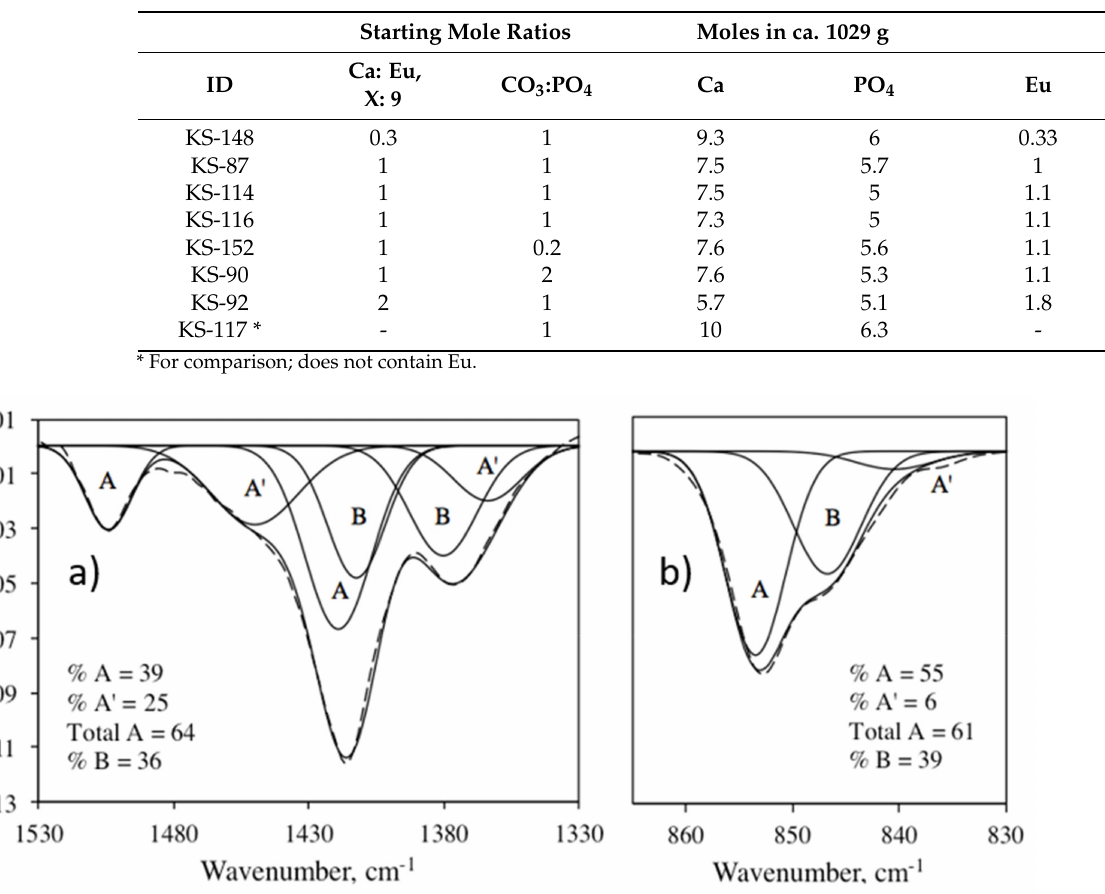
Table 3. Experimental molar amounts of constituents in products.